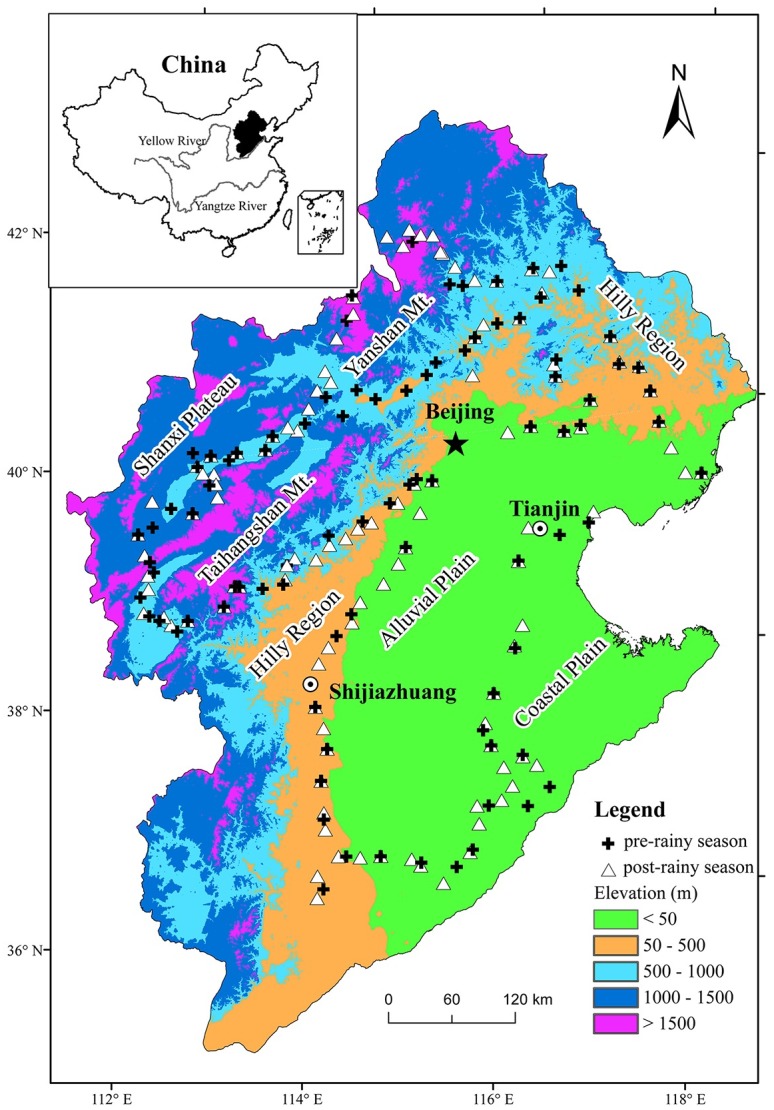
Location of the research region and sampling sites.(The China map was generated using free, open access data sources from the National Geomatics Center of China)